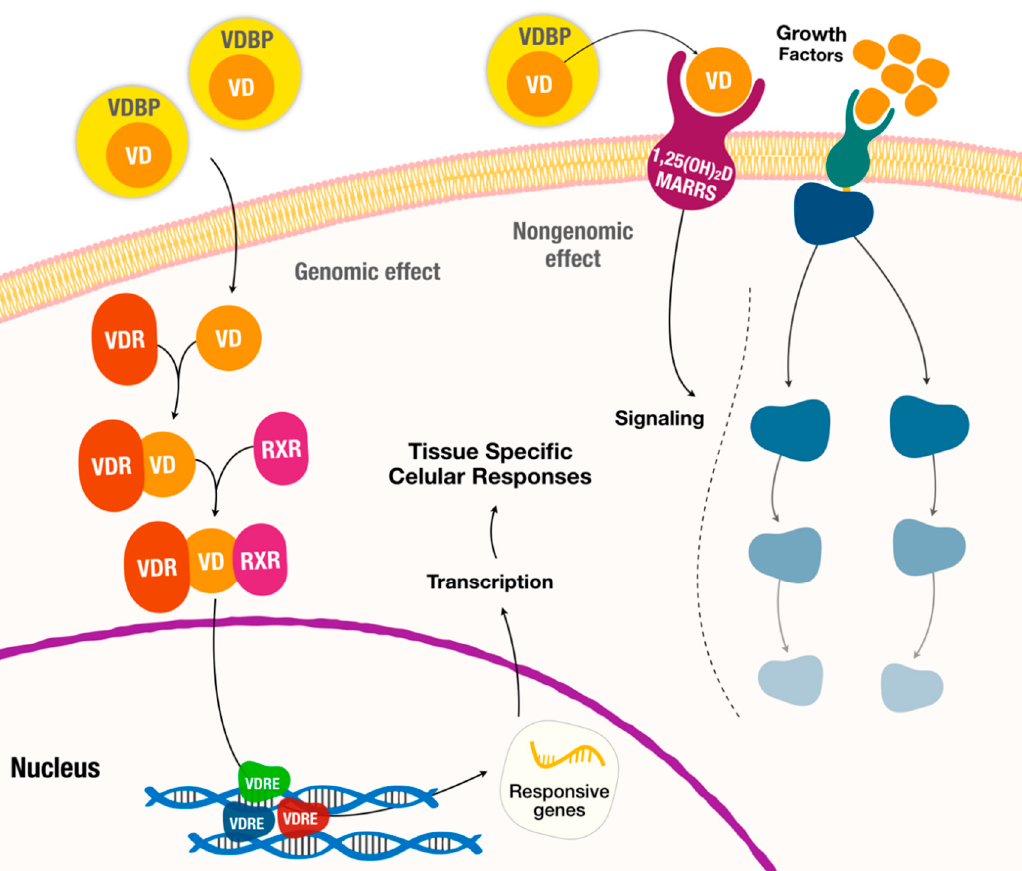
Figure 2. Hormonal actions of Vitamin D with genomic and nongenomic effects. MARRS-membrane-associated, rapid response steroid-binding protein; RDR—retinoid-X receptor; VD—Vitamin D; VDR—Vitamin D Receptor; VDRE—Vitamin D response elements; VDBP–Vitamin D-binding protein.